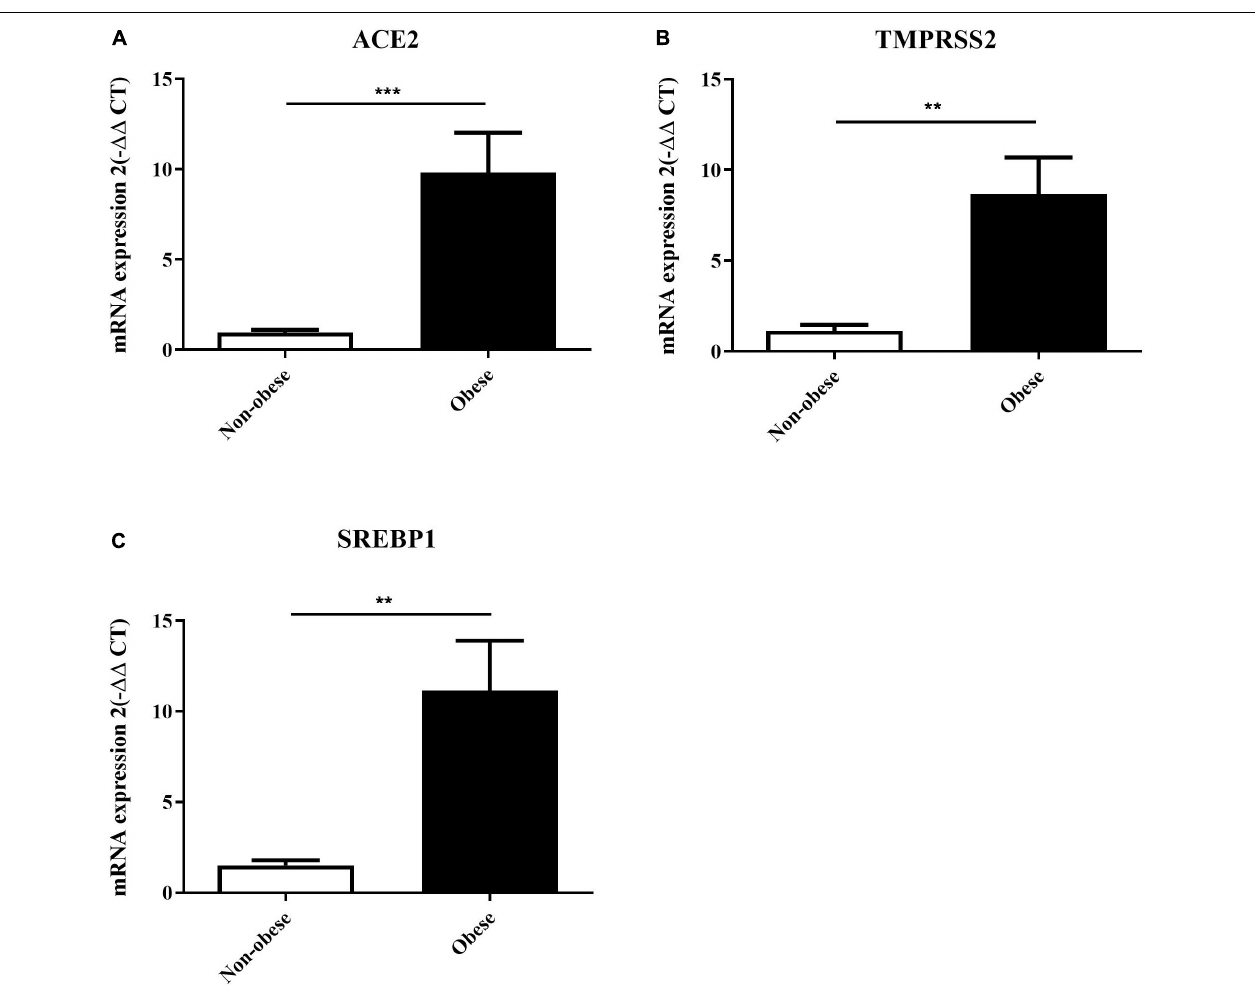
FIGURE 9 | ACE2, TMPRSS2, and SREBP1 expression are increased in lung epithelial cells of obese subjects. Lung epithelial cells from non-obese ( n = 4) and obese ( n = 3) were used to assess mRNA expression of ACE2 (A) , TMPRSS2 (B) , and SREBP1 (C) . ** p < 0.01, *** p < 0.001.